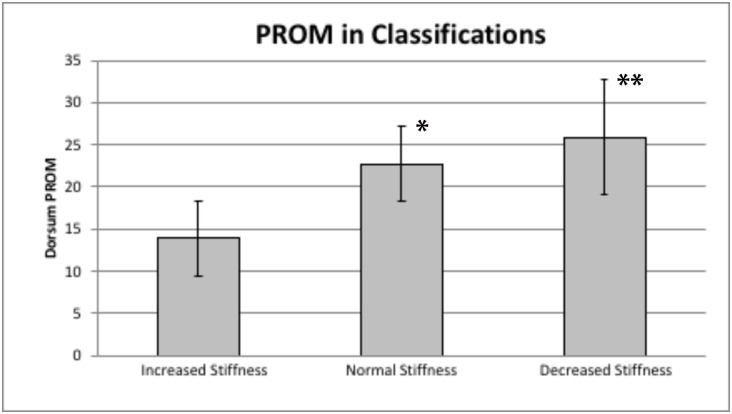
Histogram of dorsum PROM divided into classifications and measured with an electrogoniometer.Included data are mean and 95% CI (error bars). The Normal Stiffness group (*) and Decreased Stiffness group (**) mean scores each demonstrated significantly greater PROM versus the Increased Stiffness group.